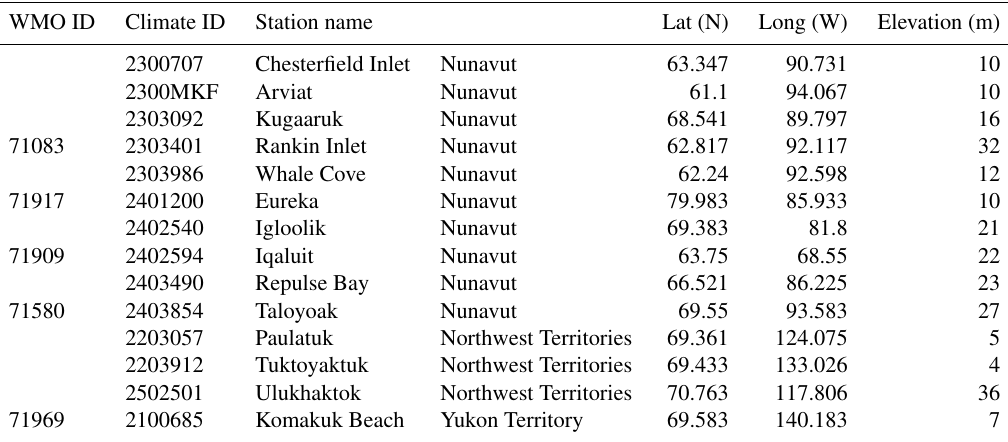
Table 1. Stations in Canadian Arctic Archipelago (CAA) selected for comparison with reanalysis datasets. WMO